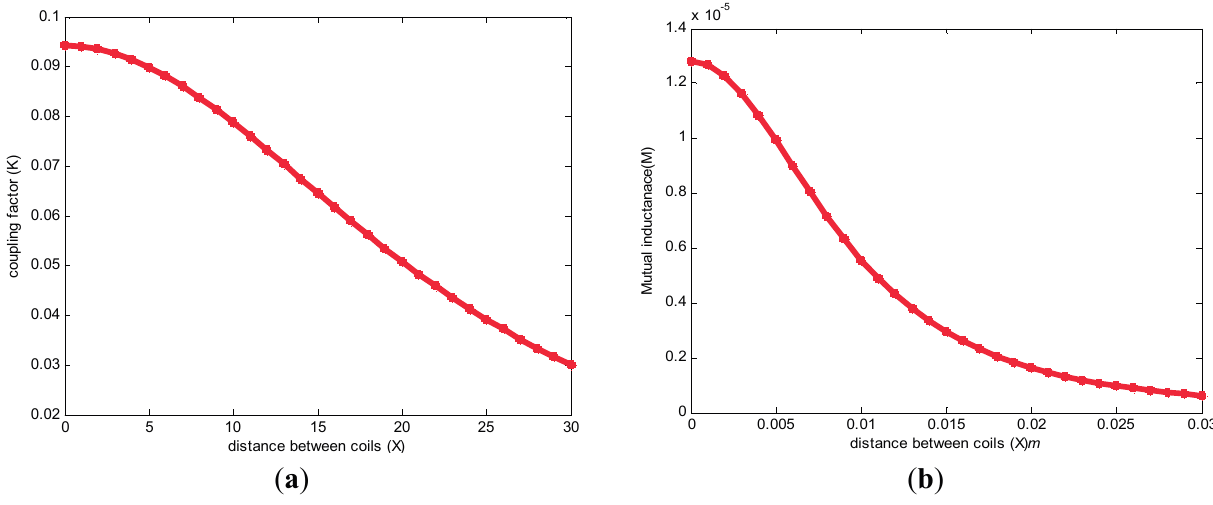
Figure 4. the relationship between ( a ) Coupling coefficient; ( b ) mutual inductance and distance between two